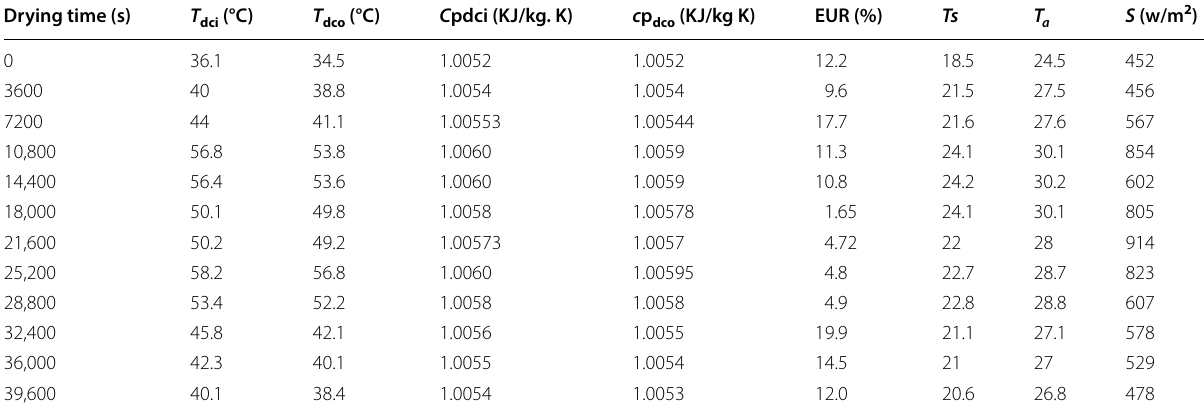
Table 13 Result energy analysis tomato 1st day